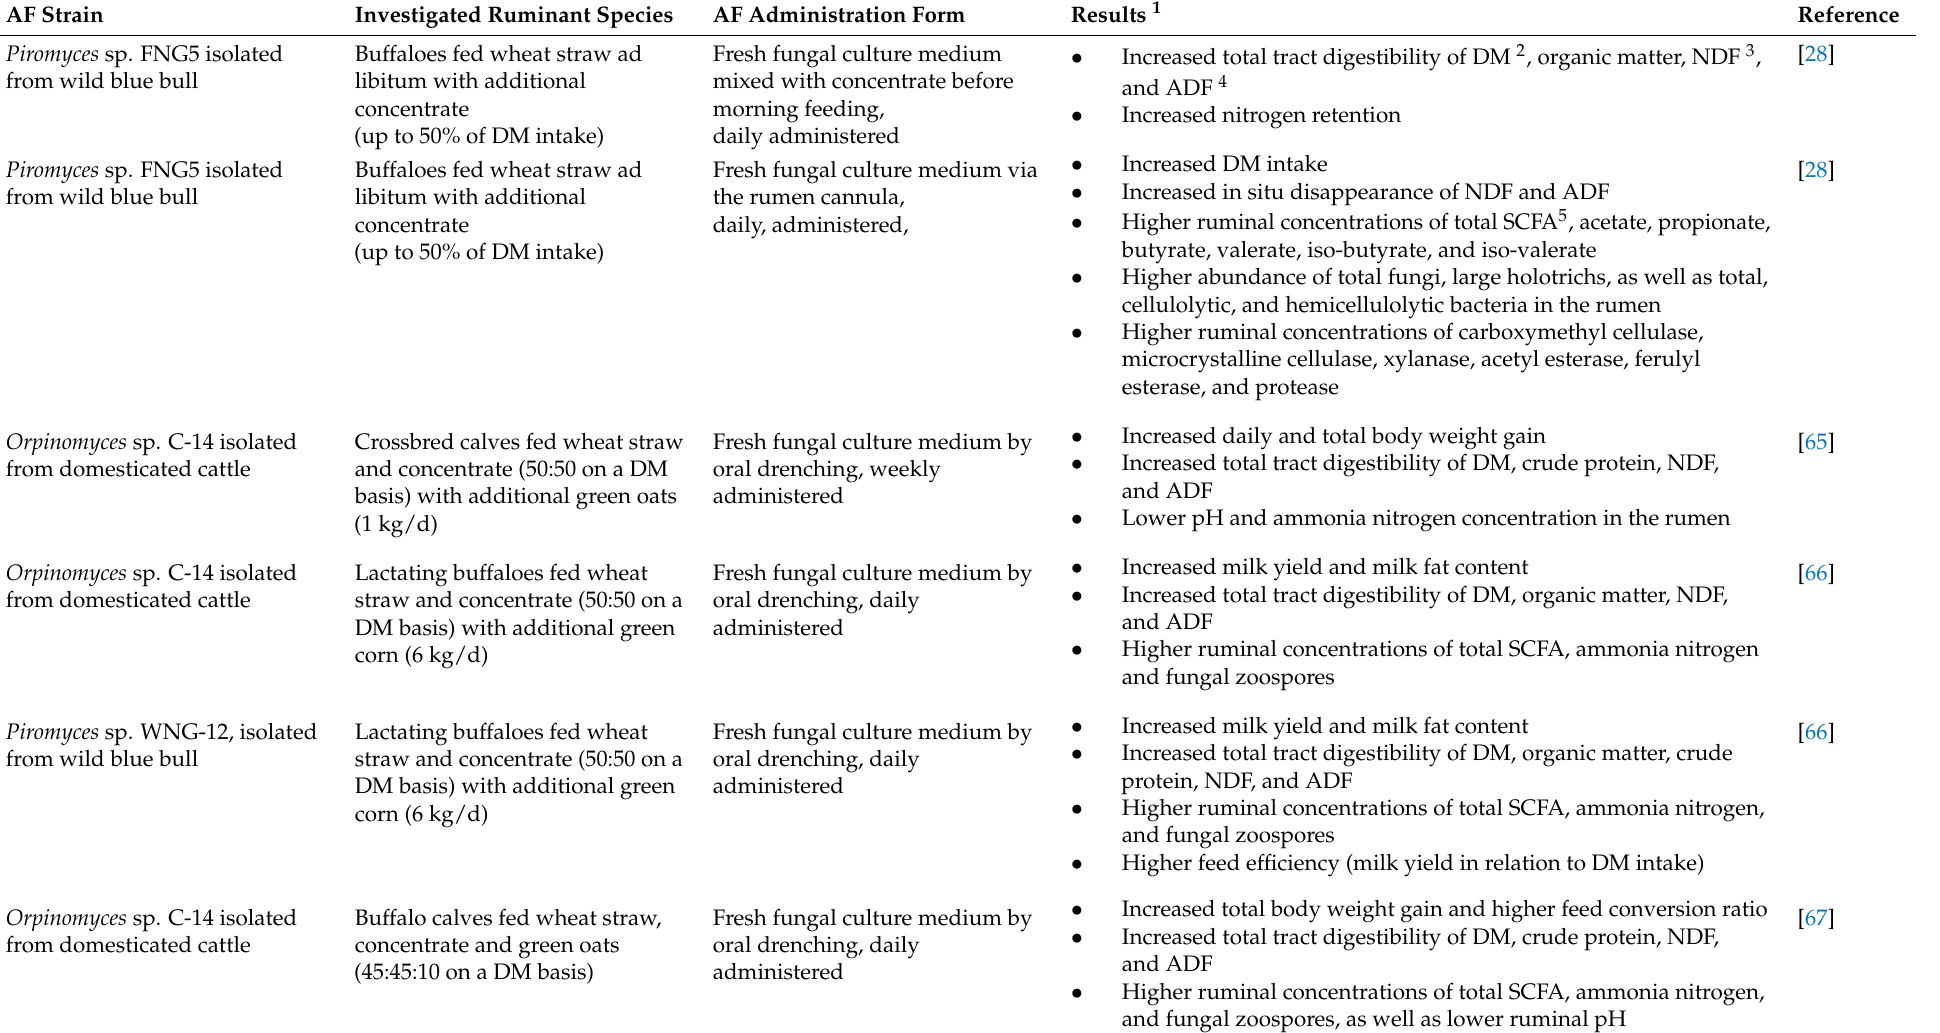
Table 1. Overview of studies investigating anaerobic fungi (AF) as feed additives in